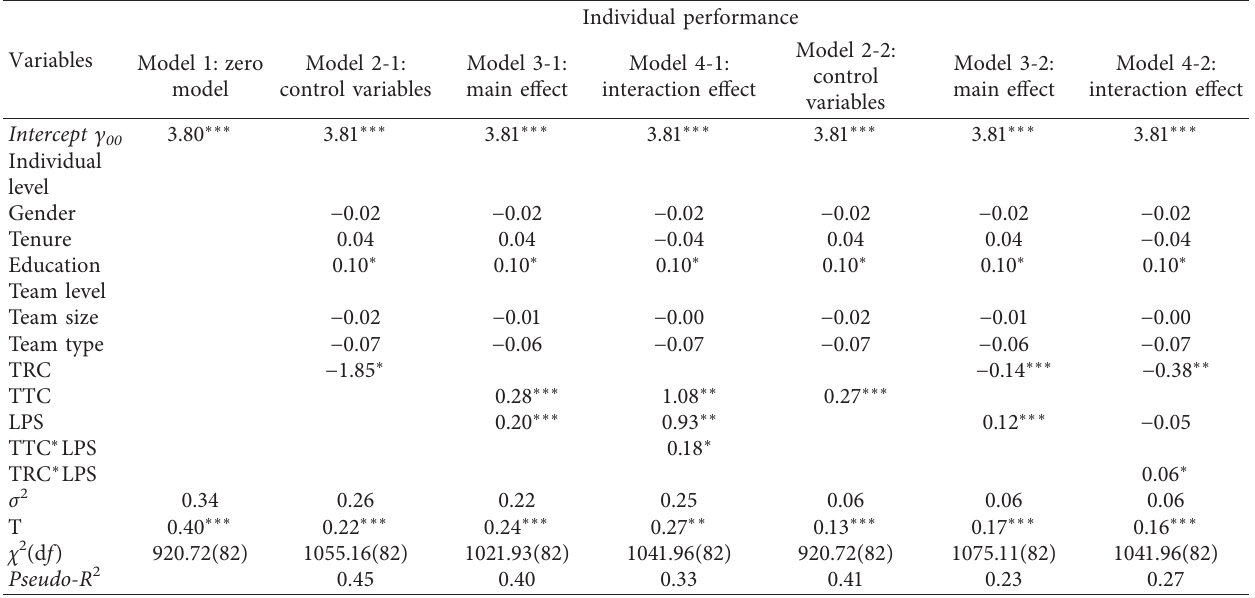
Table 2: Effects of leader political skills on the relationship between team conflict and individual